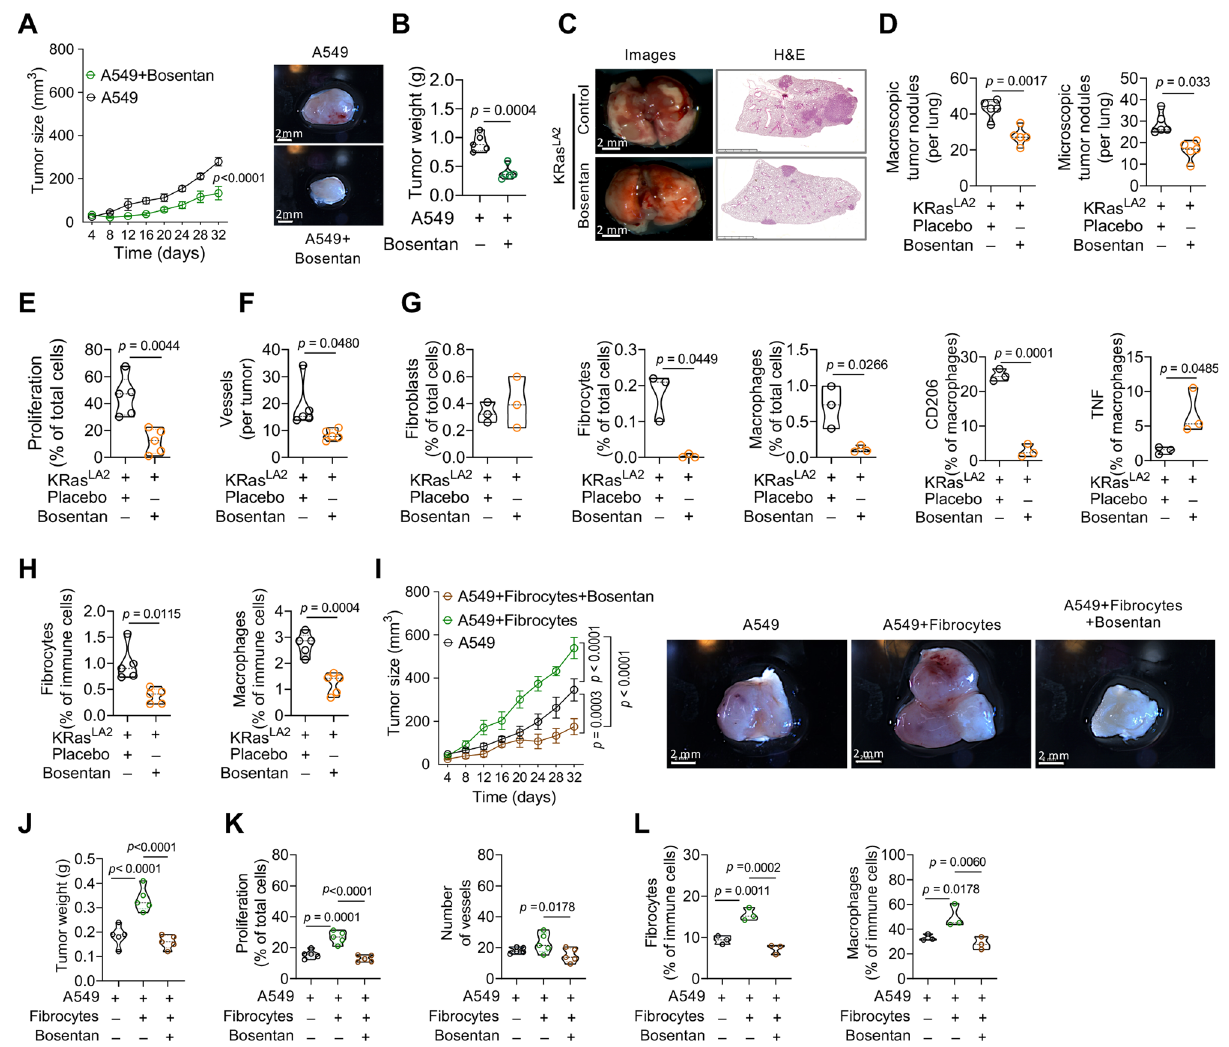
I – L A549 or A549+ fi brocytes were subcutaneously (s.c.) injected in BALB/c